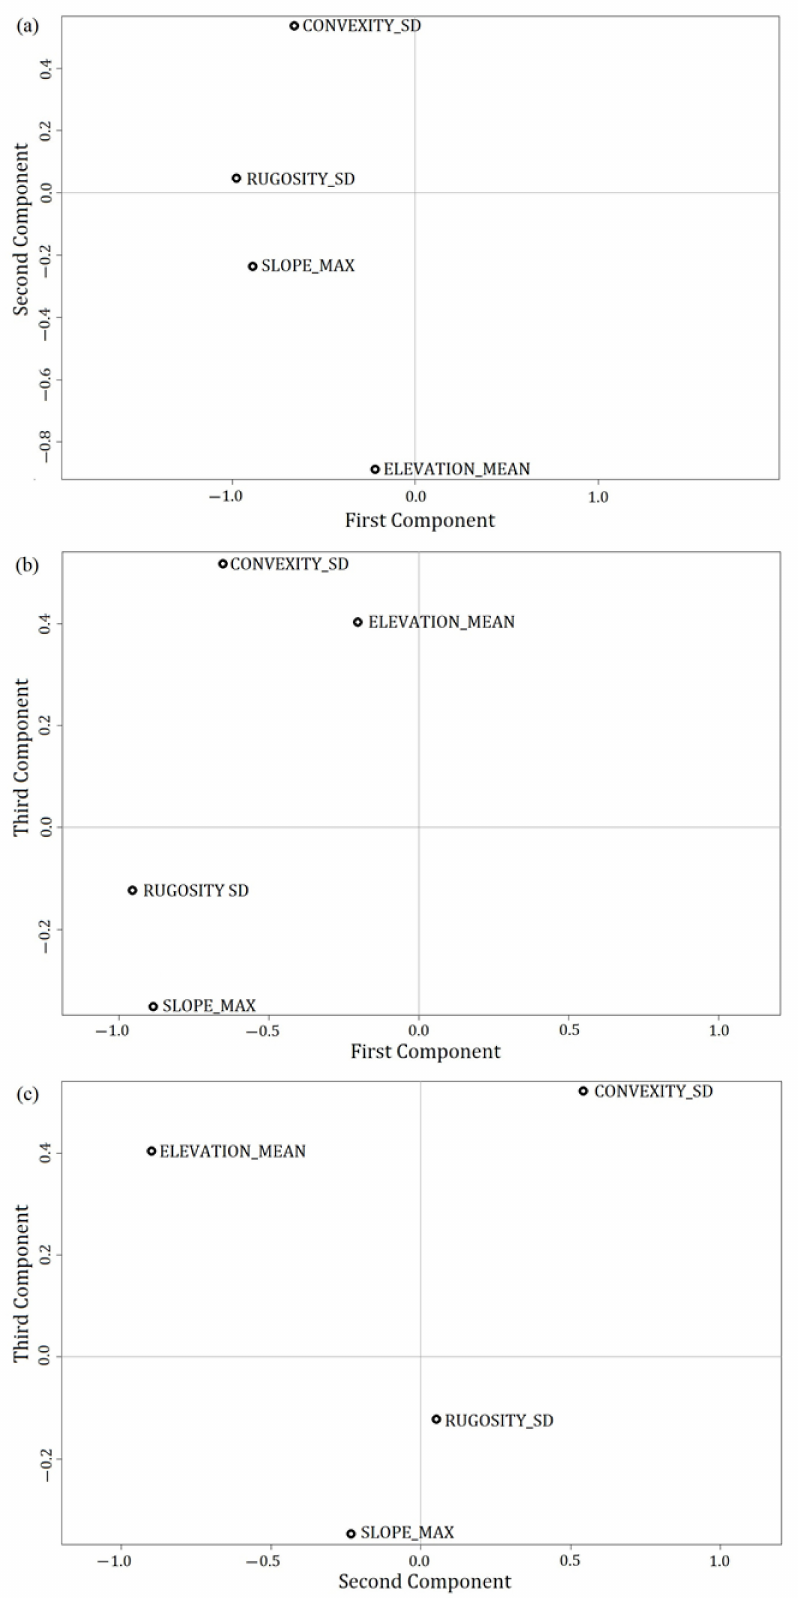
Figure 4. Correlations diagram between components and topographic variables of ( a ) components 1 and 2; ( b ) components 1 and 3; and ( c ) components 2 and